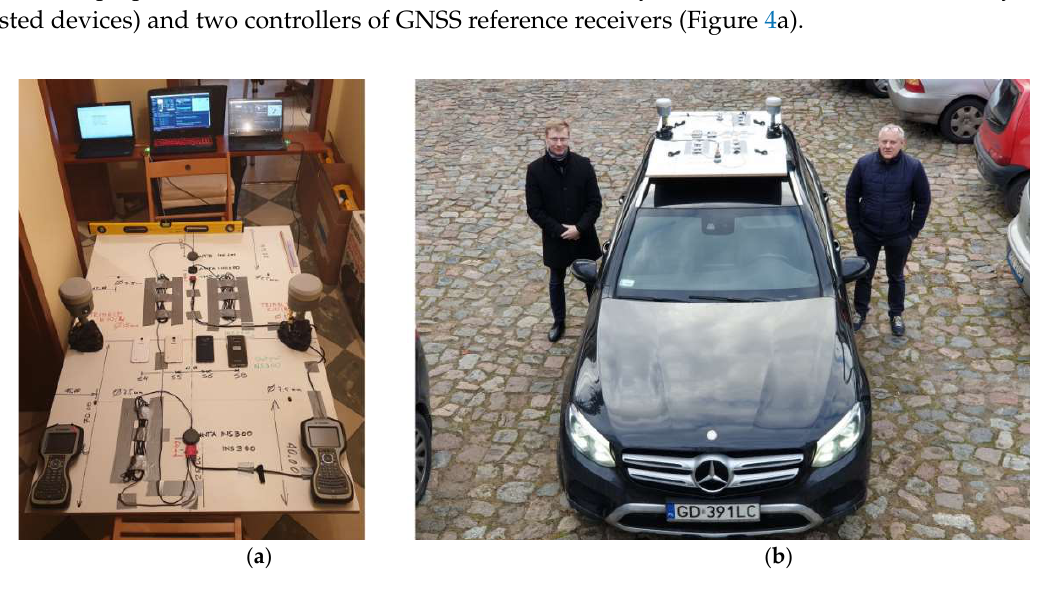
Figure 4. Testing electrical connections of the measurement equipment ( a ) and a plate with measurement equipment assembled on a passenger car ( b ).